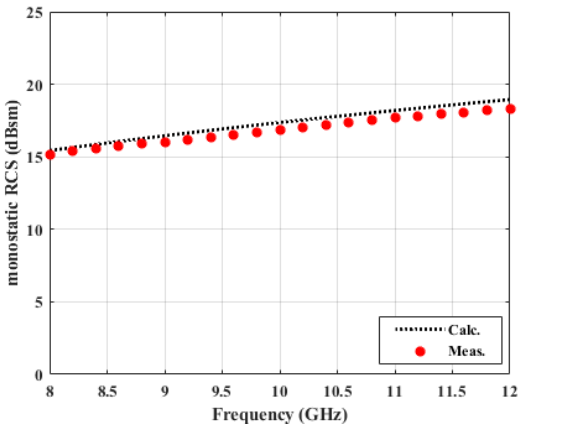
Figure 3. Monostatic RCS calibration (copper plate, 20 cm × 20